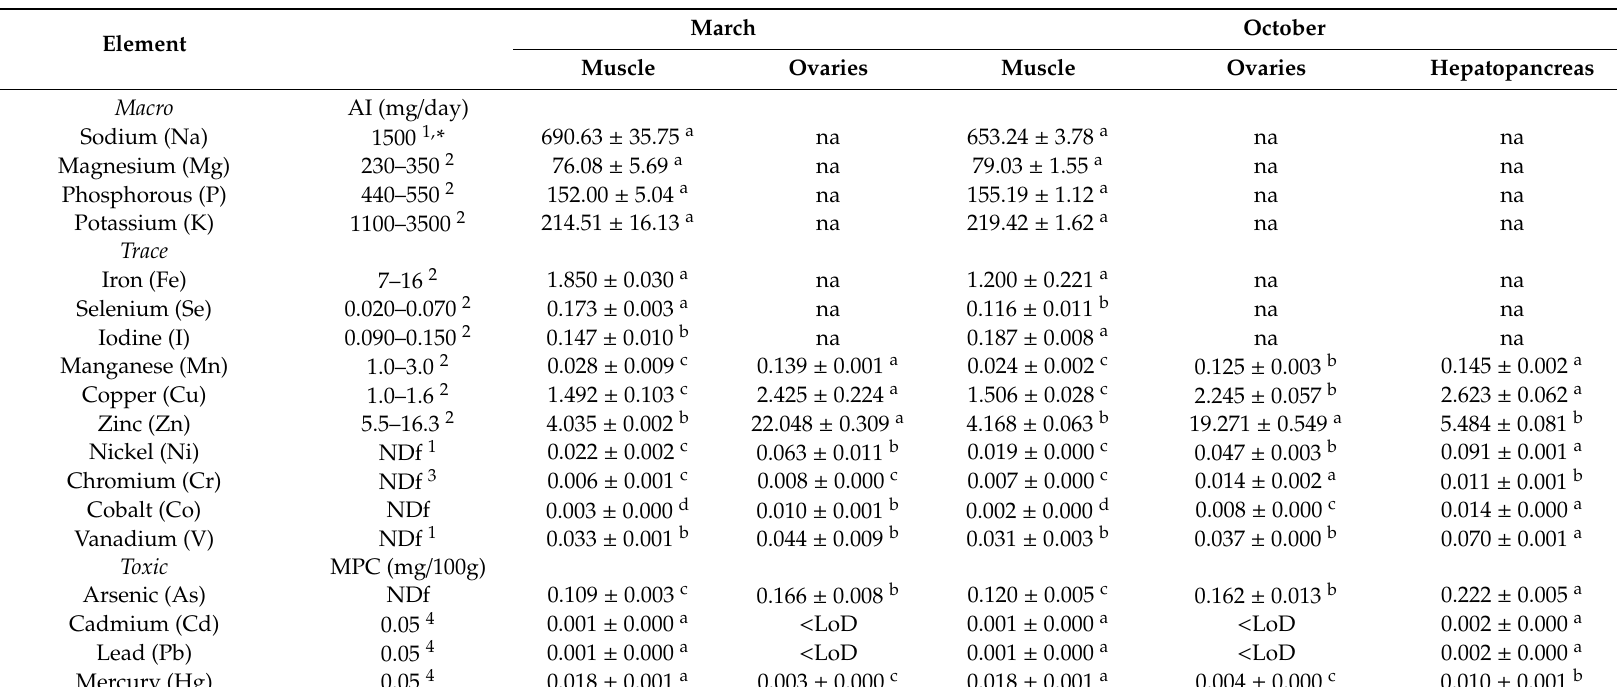
Table 6. Concentration of macro, trace, and toxic elements (mg / 100 g wet weight) of the edible tissues of boiled C. maritae caught in March and October (average ± standard